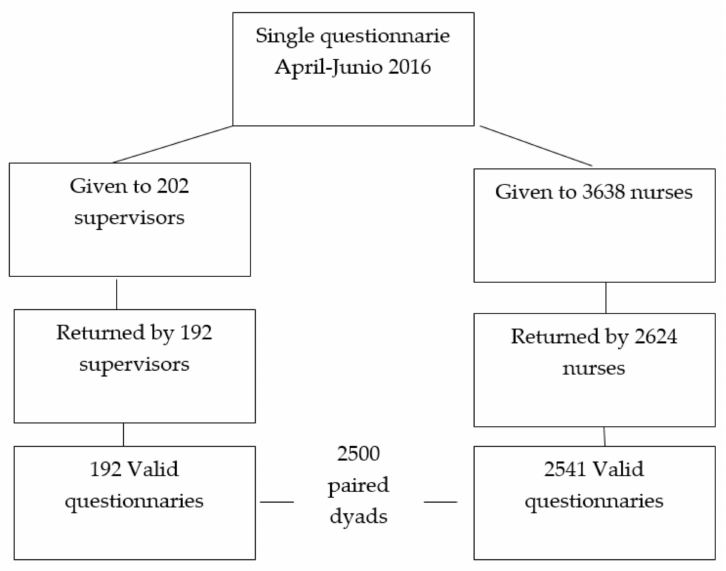
Figure 2. Study flow